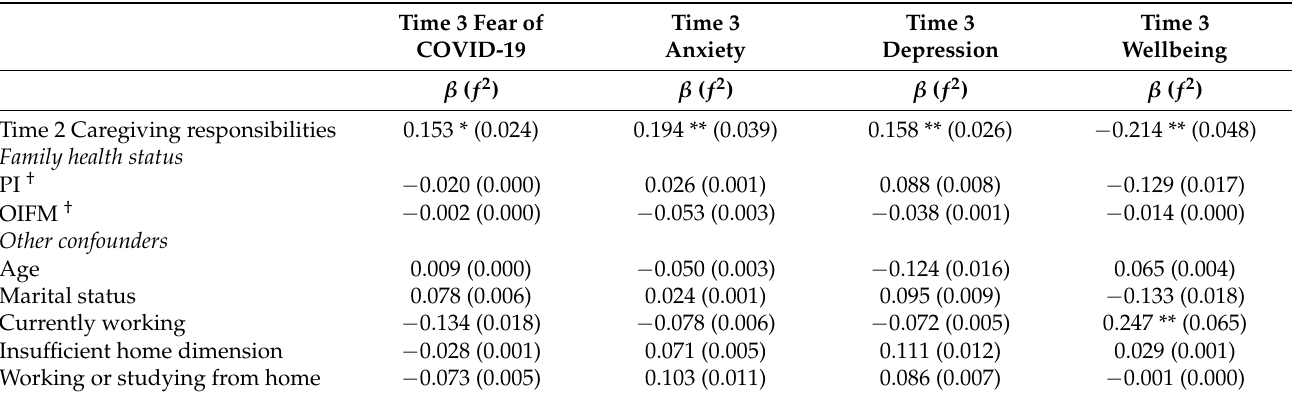
Table 3. Linear Regressions of Time 2 Caregiving Responsibilities Predicting Time 3 Mental Health Outcomes. Time 3 Fear of COVID-19